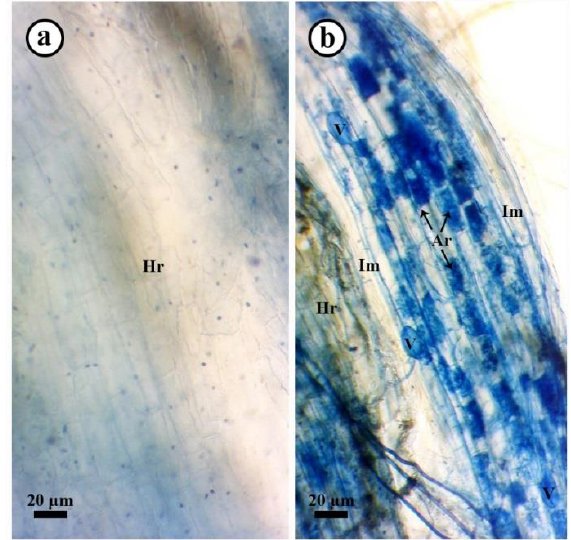
Figure 4. Typical mycorrhizal structures in pea roots colonized with R. irregularis . Where ( a ) non- mycorrhizal root (bar = 20 μm), and ( b ) mycorrhizal roots (bar = 20 μm). Where Hr: host root, Im: interaradical mycelia, V: vesicle, and Ar: arbuscule.